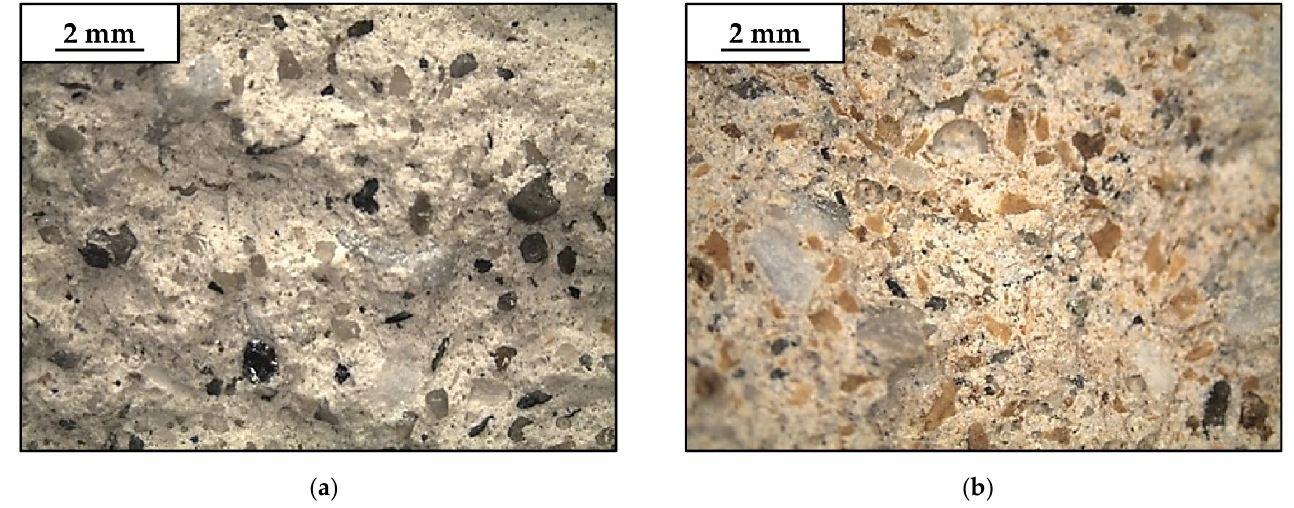
Figure 4. Optical microscopy images at 8× magnification of mortars containing 0 wt% ( a ) and 4 wt% ( b ) of cork waste.